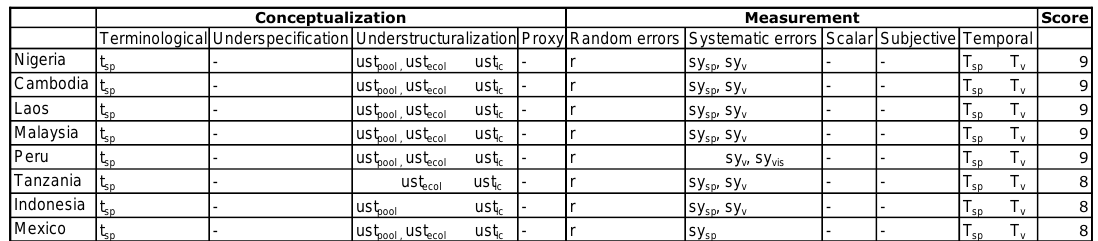
Figure 7. Uncertainty Fingerprints for the comprehensive group of six tropical countries of estimates